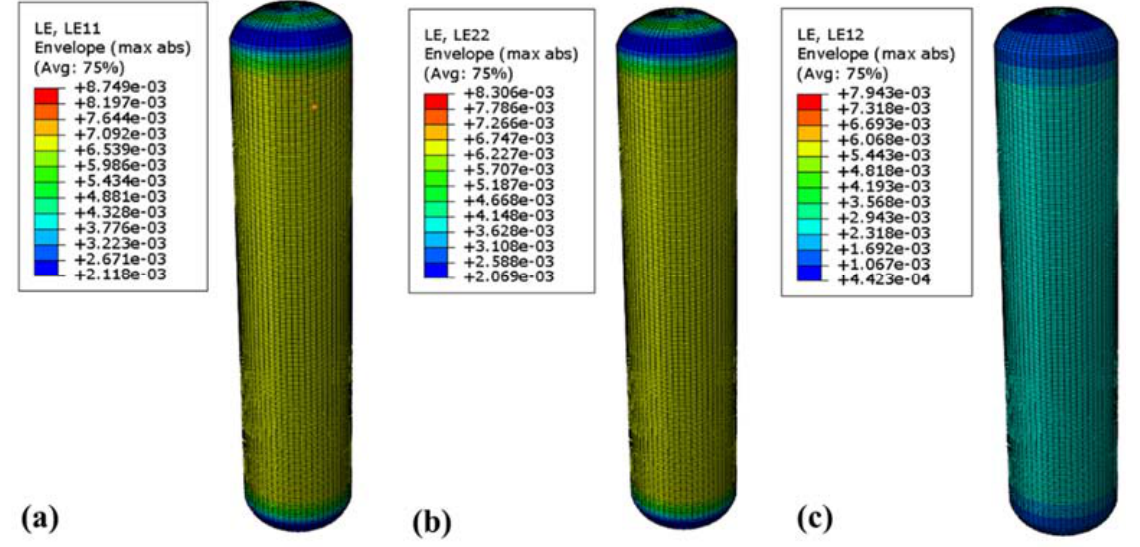
Figure 11. Strain distribution cloud map of 70 MPa winding layer: ( a ) strain cloud diagram in fiber direction; ( b ) strain cloud diagram perpendicular to fiber direction; ( c ) strain diagram in in-plane shear direction.